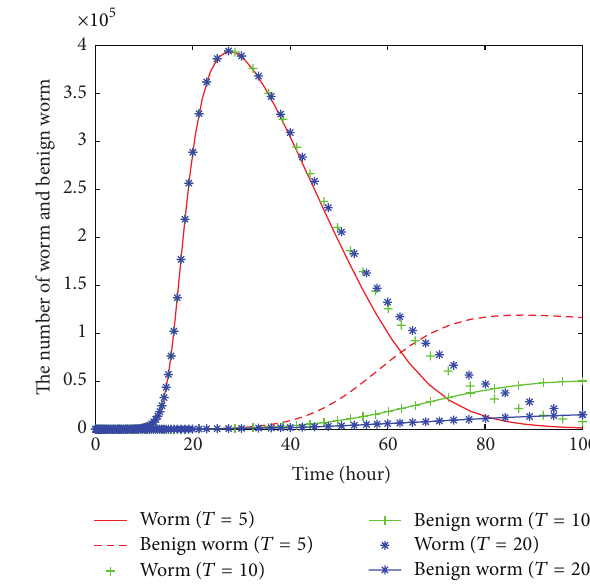
Figure 17: Mode three-TF.